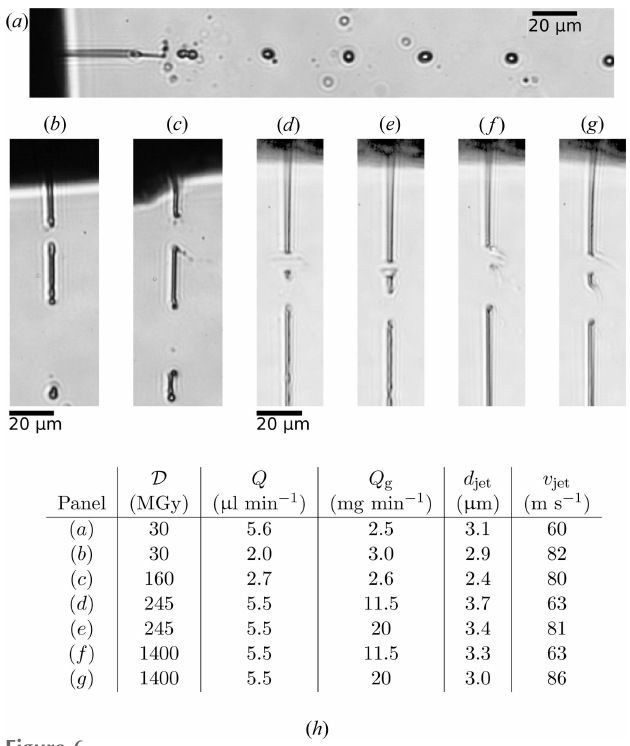
Figure 6 Comparison of the effects of X-ray-pulse structure and dose on different jets. ( a ) Awater jet similar to the one shown in Figs. 4 and 5, exposed to a full train of 250 X-ray pulses at a repetition rate of 1 MHz, measured 90.1 s; after the initial pulse. ( b ) A thinner and faster water jet exposed to the same pulse train structure, measured 3.14 s after the initial pulse. ( c ) An ethanol jet also exposed to the same pulse train structure and measured at the same delay. ( d ) A slow water jet exposed to two FLASH pulses with a spacing of 221.5 ns. ( e ) A faster water jet exposed to the double-pulse, measured 50 ns after the second pulse. ( f ) A slow ethanol jet that barely recovers before the second X-ray pulse hits it 221.5 ns later, as measured 50 ns after the second pulse. ( g ) A fast ethanol jet under the same conditions. ( h ) A table with the experimental conditions of the jets shown in panels ( a )–( g ). The jets shown in ( a )–( c ) were formed with one particular nozzle and ( d )–( g ) were formed with another. A slice through an X-ray tomogram of the latter nozzle is shown in Fig. 1. The ethanol jets, especially ( f ) and ( g ), exhibit a non-symmetric gap formation where the jet explosion is directed towards the right side. The X-ray beam is incident from the left and is strongly absorbed at the surface of the jet. The energy deposition into the jet is consequently non-uniform.